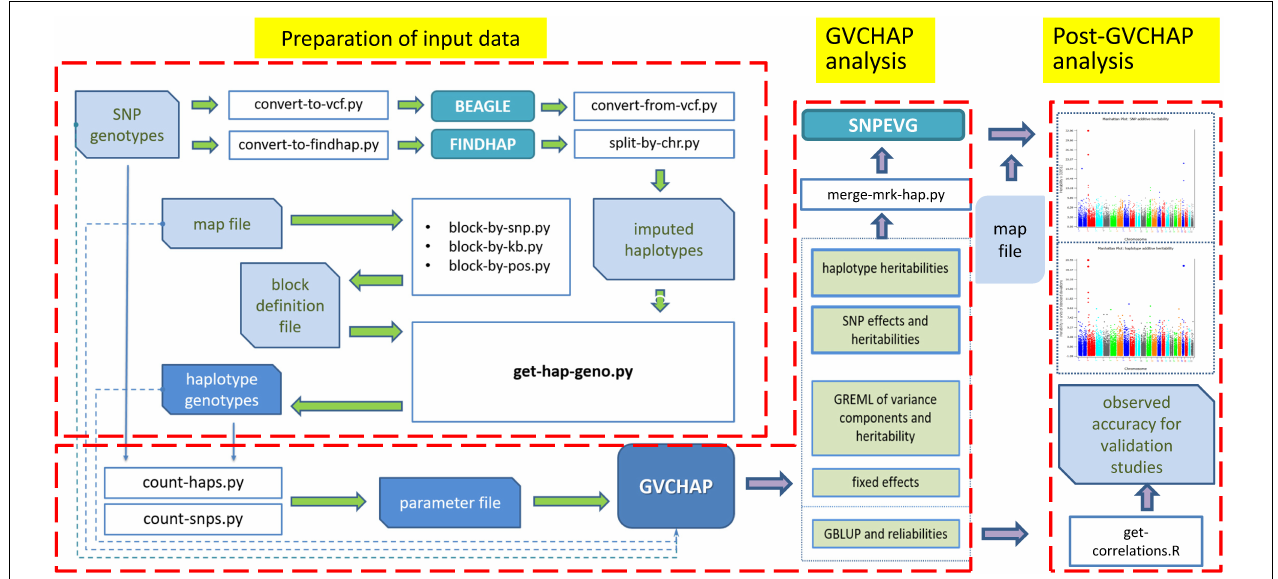
FIGURE 1 | Structure of GVCHAP computing pipeline. The pipeline consists of three components, preparation of input data for haplotype analysis, GVCHAP analysis of genomic prediction and estimation, and post-GVCHAP